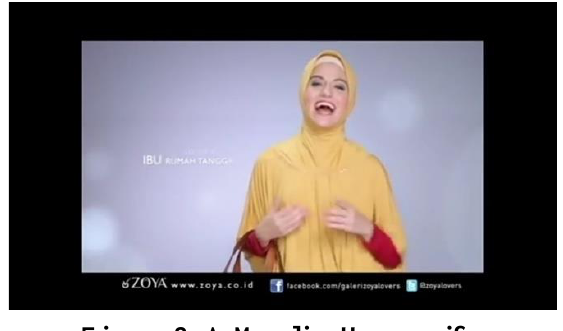
Figure 8: A Muslim